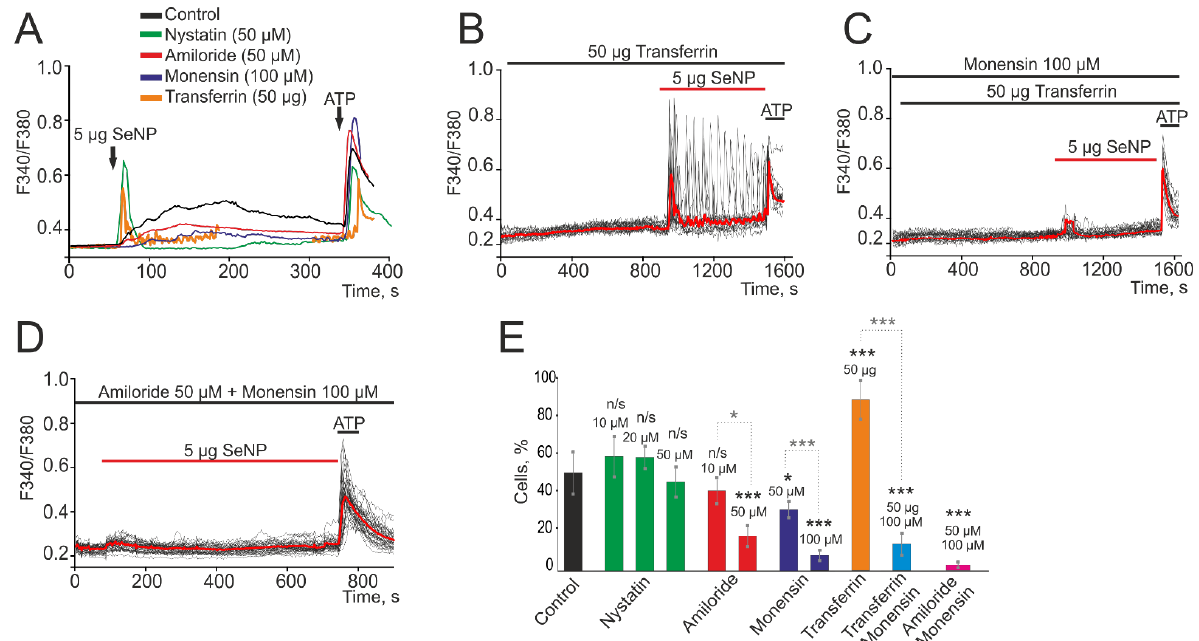
Figure 2. Contribution of micropinocytosis, caveolar, and clathrin-associated endocytosis to the generation of Ca 2+ signals in A-172 cells upon application of 5 µg/mL SeNP. ( A ) Average values of Ca 2+ signals caused by the application of 5 µg/mL SeNP over several tens of cells in the control (black curve) and after 2 h incubation of cells with a blocker of caveolar endocytosis (green curve, Nystatin, 50 µM), micropinocytosis (red curve, Amiloride, 50 µM), and clathrin-associated endocytosis (purple curve, Monensin, 100 µM). The potentiating effect of a receptor-mediated clathrin-associated endocytosis activator, Transferrin (orange curve, 50 µM), on Ca 2+ signals upon SeNP application. ( B ) Application of SeNP after incubation with Transferrin tends to increase the amplitude of Ca 2+ signals. ( C ) The blockade of clathrin-associated endocytosis with Monensin reverses the potentiating effect of Transferrin on Ca 2+ signals upon application of SeNP. ( D ) Complete suppression of Ca 2+ signals in cells in response to the application of 5 µg/mL SeNPs after simultaneous inhibition of micropinocytosis and clathrin-associated endocytosis. At the end of the experiment, 10 μM adenosine triphosphate (ATP) was added. ( E ) The number of cells in percentage ratio, reacting with Ca 2+ signals upon application of 5 µg/mL SeNPs during inhibition of various types of endocytosis or activation of a receptor-mediated clathrin-associated endocytosis. The differences between the control and experimental groups are marked with asterisks—* p < 0.05 and *** p < 0.001. n/s—differences insignificant.